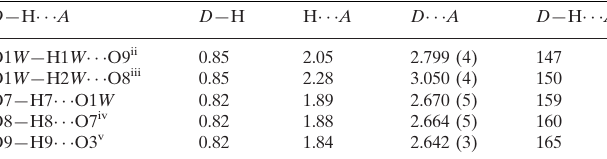
Hydrogen-bond geometry (A˚ , (cid:3)